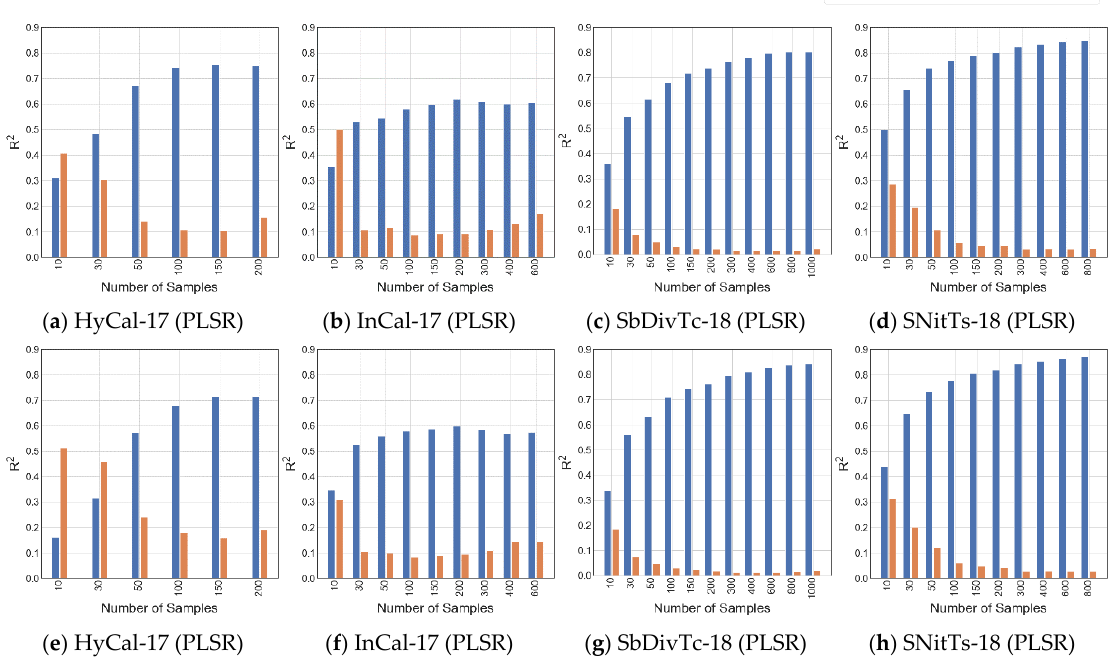
Figure 1. Impact of the number of samples on R 2 of the predictive models using SVR and PLSR models.